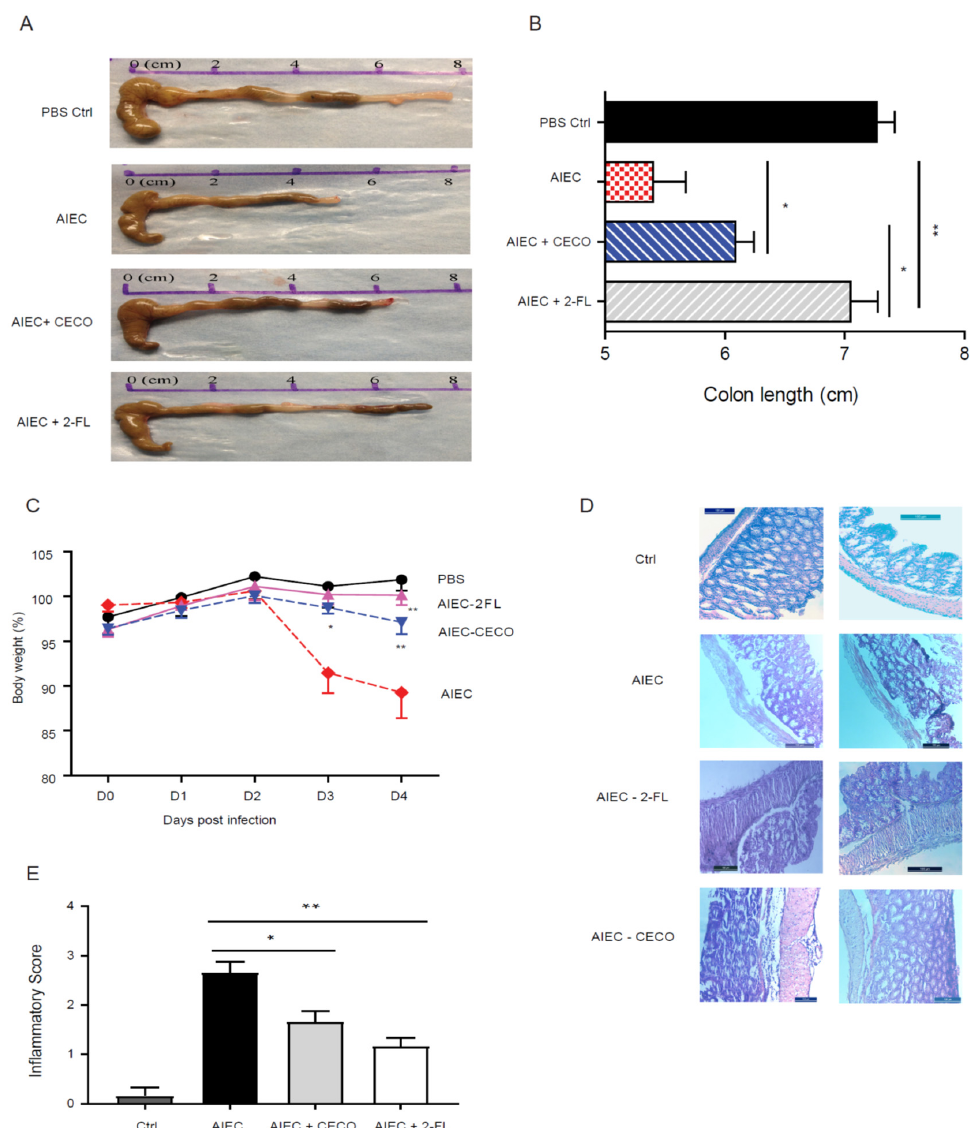
Figure 5. Human colostrum exosome oligosaccharides (CECO) attenuate inflammation in adherent-invasive E. coli (AIEC) infected mice. C57BL/6 mice received 0.25% dextran sodium sulfate (DSS) in their drinking water for 3 days, and were given 20 mg of streptomycin by gavage on day 4; two group mice also received 100 mg of 2 ′ -FL/CECOs in 200 μ L by gavage for each of the 4 days, respectively. On the 5th day, the two groups of experimental mice were inoculated with 10 9 colony forming unit (CFU) AIEC via gavage and sacrificed after 4 days; a control group received DSS and antibiotic, but only a sham PBS inoculum. The comparison of reduction in colon length caused by AIEC infection did not occur with CECOs pretreatment ( A , B ). The body weight loss that follows AIEC infection did not occur with 2 ′ -FL and CECOs pretreatment ( C ). Comparison of H&E stained colon sections image ( D ) and inflammation score ( E ) from AIECs infected mice without or with CECOs and 2 ′ -FL pretreatments. Representative images from six mice. Bars = 100 μ m. Mean ± SEM, n = 6 for all groups; * p ≤ 0.05; ** p ≤ 0.01 by analysis of variance.